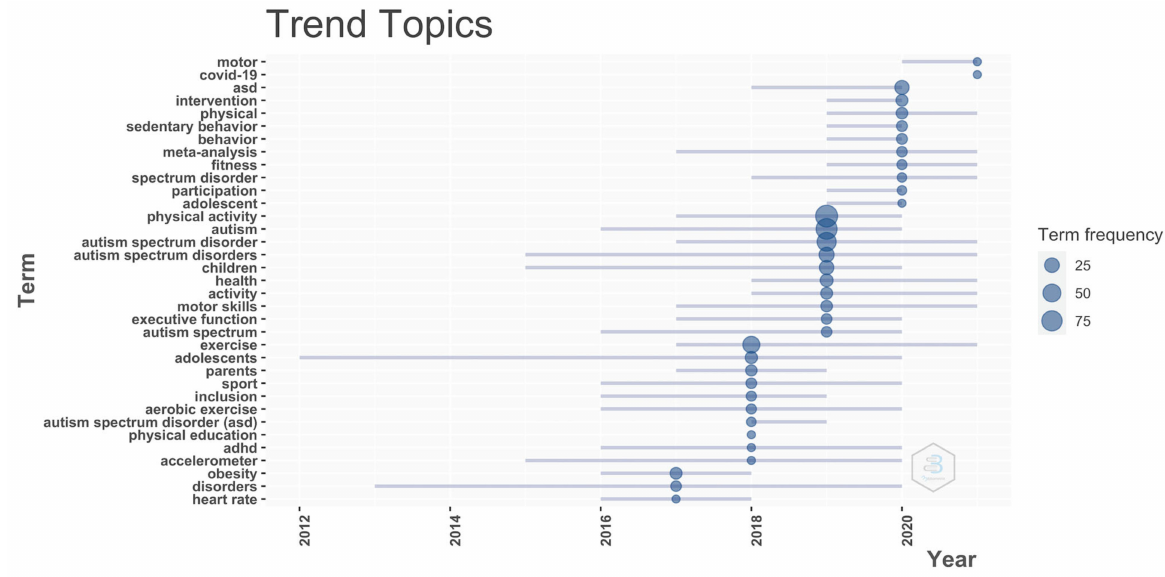
Figure 10. The topic trends of PA research on ASD over the last five